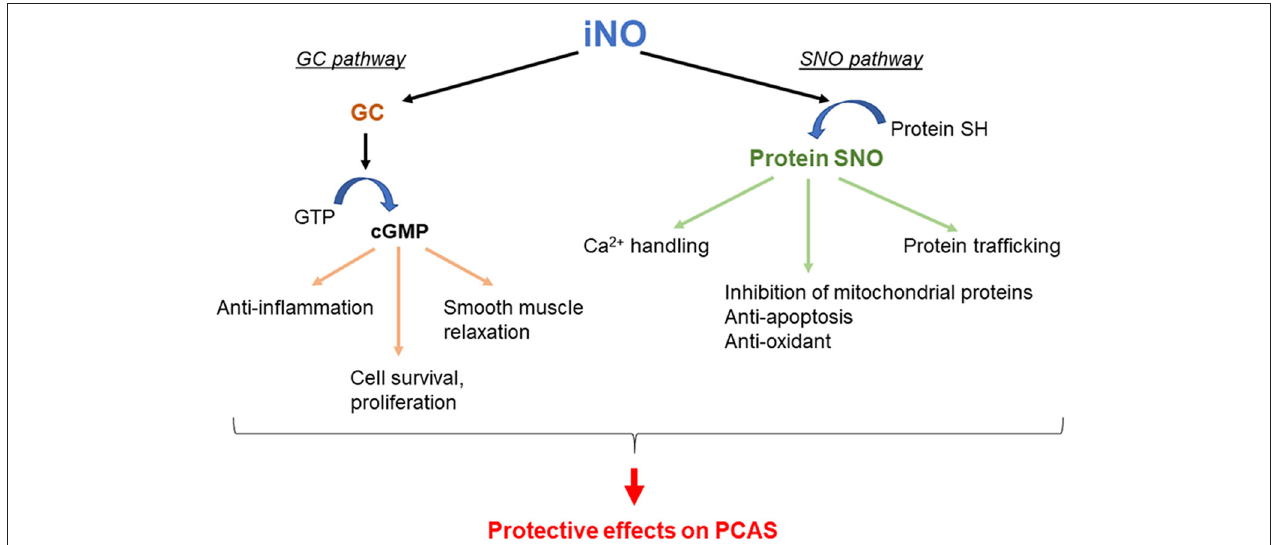
FIGURE 1 | Potential mechanisms by which inhaled nitric oxide (iNO) improves outcomes in post–cardiac arrest syndrome (PCAS). GC, guanylyl cyclase; GTP, guanosine triphosphate; cGMP, cyclic guanosine monophosphate; SNO, S-nitrosylation.